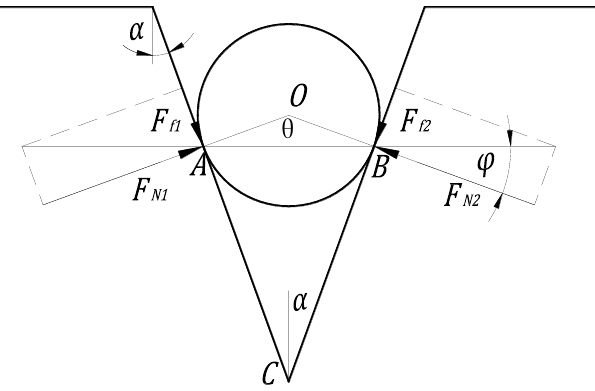
Figure 5. Schematic of the clamped stalk.